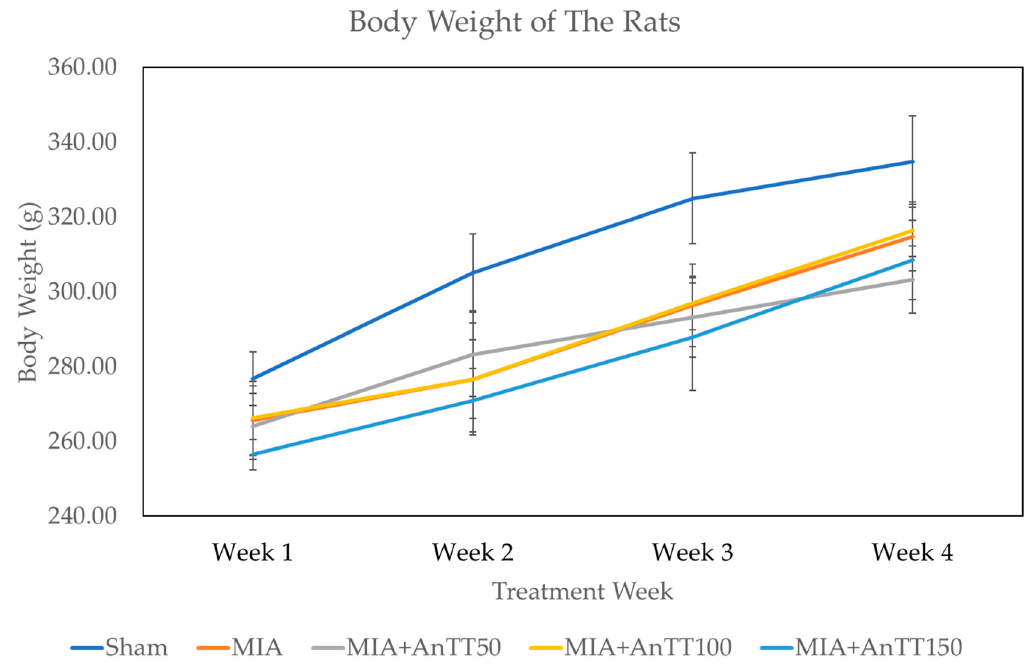
Figure 1. Body weight of the rats throughout the study period. The body weight was measured at the beginning of the week. No statistically significant intergroup difference at each time point was found.